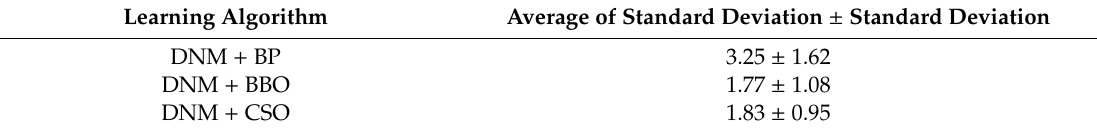
Table 17. Average of standard deviation of accuracy and standard deviation of each method for the tests.